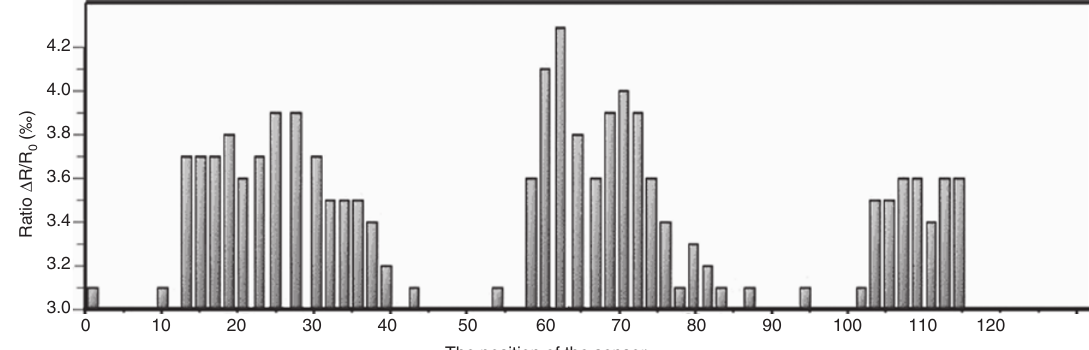
Figure 11: Resistance changes of the carbon nanotube thread in a row.